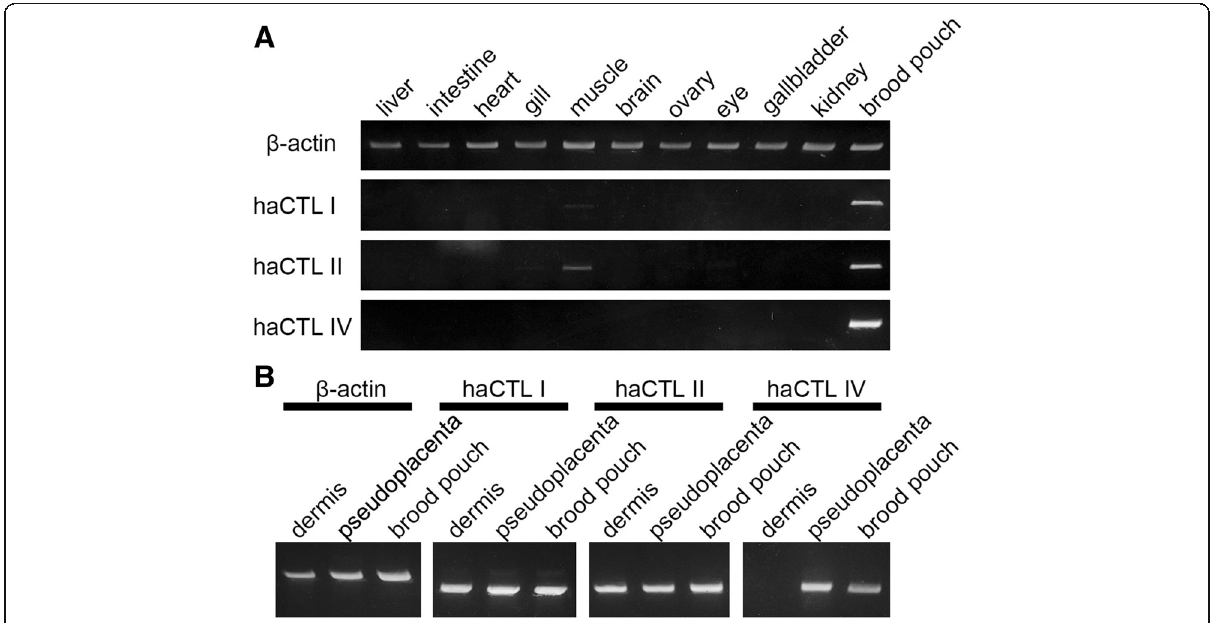
Fig. 8 Semi-quantitative analysis of C-type lectin gene expression. a Semi-quantitative expression analysis of C-type lectin genes in adult seahorse liver, intestine, heart, gill, muscle, brain, ovary, eye, gallbladder, kidney, and late-stage brood pouch. b Comparison of C-type lectin gene expression in late-stage brood pouch tissues: dermis along with outer epithelium, pseudoplacenta along with luminal epithelium, and whole brood pouch. β -actin was used